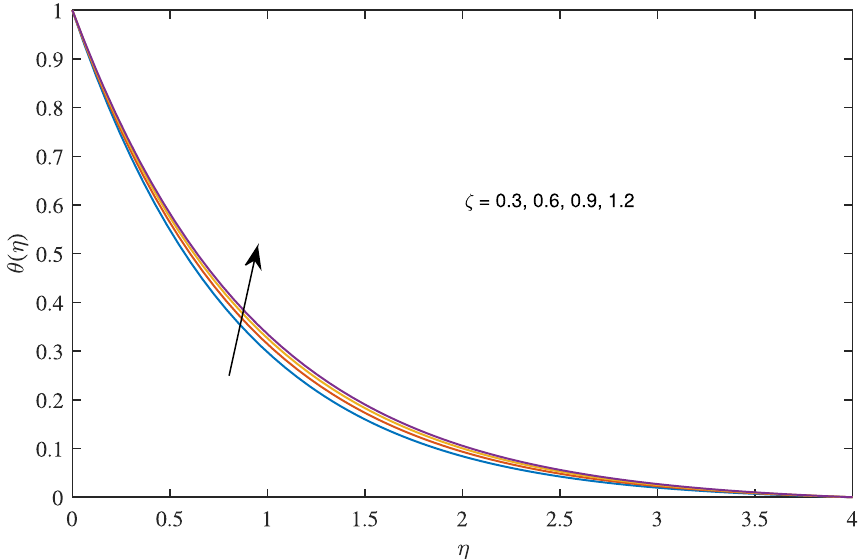
Figure 13. Effects of slip parameter ζ on temperature profile, when c 0.1 and Pr φ =